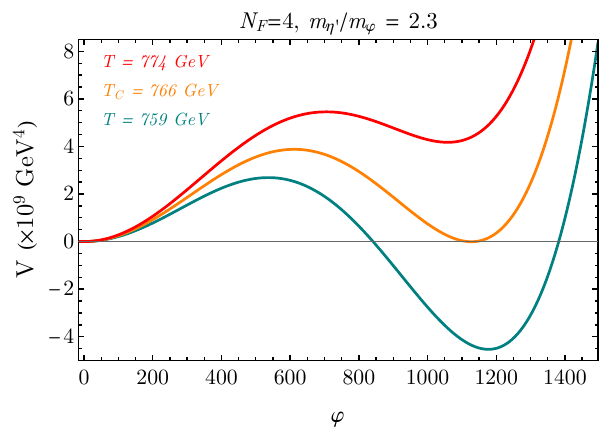
Figure 1 . Thermal potential for a benchmark with N F = 4. At zero temperature, the barrier disappears, while at high temperature, the global vacuum has vanishing vacuum expectation value h ’ i =